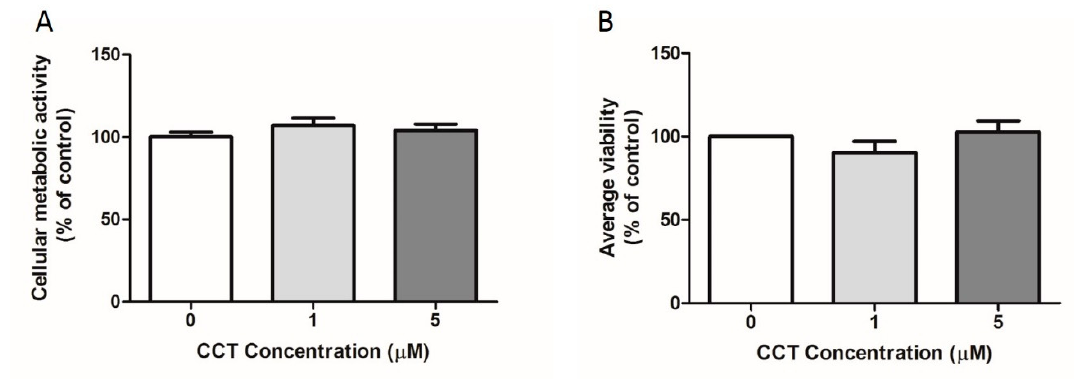
Figure 4. Effect of CCT on cell viability. The maximum viability detected for control differentiated E ff ect of CCT on cell viability. The maximum viability detected for control cells (CCT 0 μ M) was set to 100%; the relative viability of CCT-differentiated cells is shown. Values di ff erentiated cells (CCT 0 µ M) was set to 100%; the relative viability of CCT-di ff erentiated cells were obtained at the FD time-point. Data are expressed as the mean ± SD. ( A ) 3-(4,5-Dimethylthiazol- is shown. Values were obtained at the FD time-point. Data are expressed as the mean ± SD. 2-yl)-2,5-diphenyltetrazolium bromide (MTT) assay: data were obtained from at least 10 replicates in ( A ) 3-(4,5-Dimethylthiazol-2-yl)-2,5-diphenyltetrazolium bromide (MTT) assay: data were obtained each condition from three independent experiments. ( B ) Trypan blue (TB) assay: two readings were from at least 10 replicates in each condition from three independent experiments. ( B ) Trypan blue performed per well using an automated cell counter. The percentage of viable cells (alive cells with (TB) assay: two readings were performed per well using an automated cell counter. The percentage of respect to total cells) was averaged. Data were obtained from at least two replicates in each condition viable cells (alive cells with respect to total cells) was averaged. Data were obtained from at least two from three independent experiments. replicates in each condition from three independent